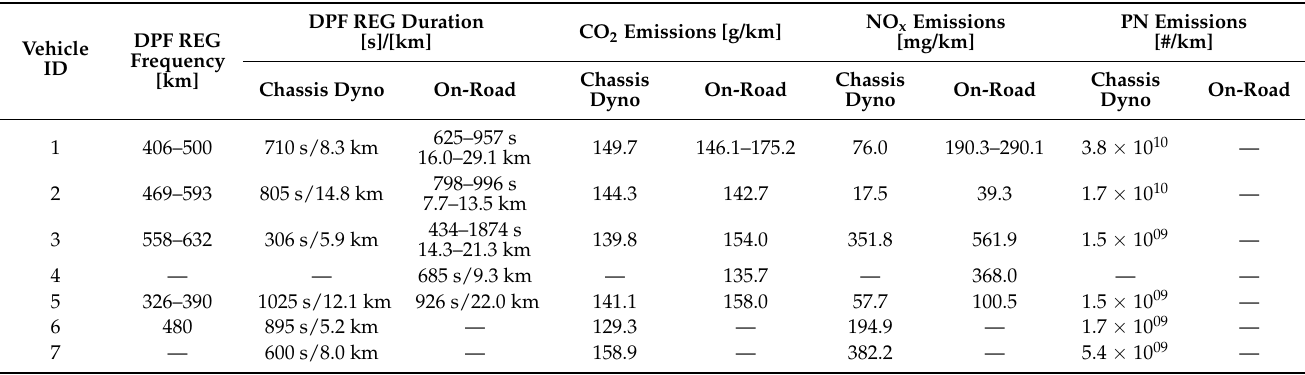
Table A5. Actual CO 2 , NO x and PN emissions throughout the complete test cycle (chassis dyno)/trip (on-road) without DPF